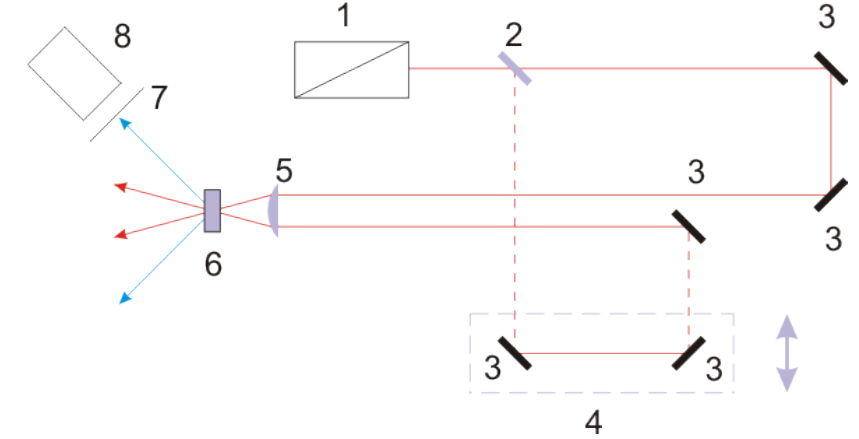
Figure 12. Optical scheme of autocorrelation measurement in nonlinear diffraction from virtual beam (NLDVB) geometry. 1-Tsunami oscillator; 2-beamsplitter; 3-mirror; 4-delay line; 5-focusing lens; 6-NPC SBO; 7-BG39 filter; 8-918D-UV-OD3 sensor.